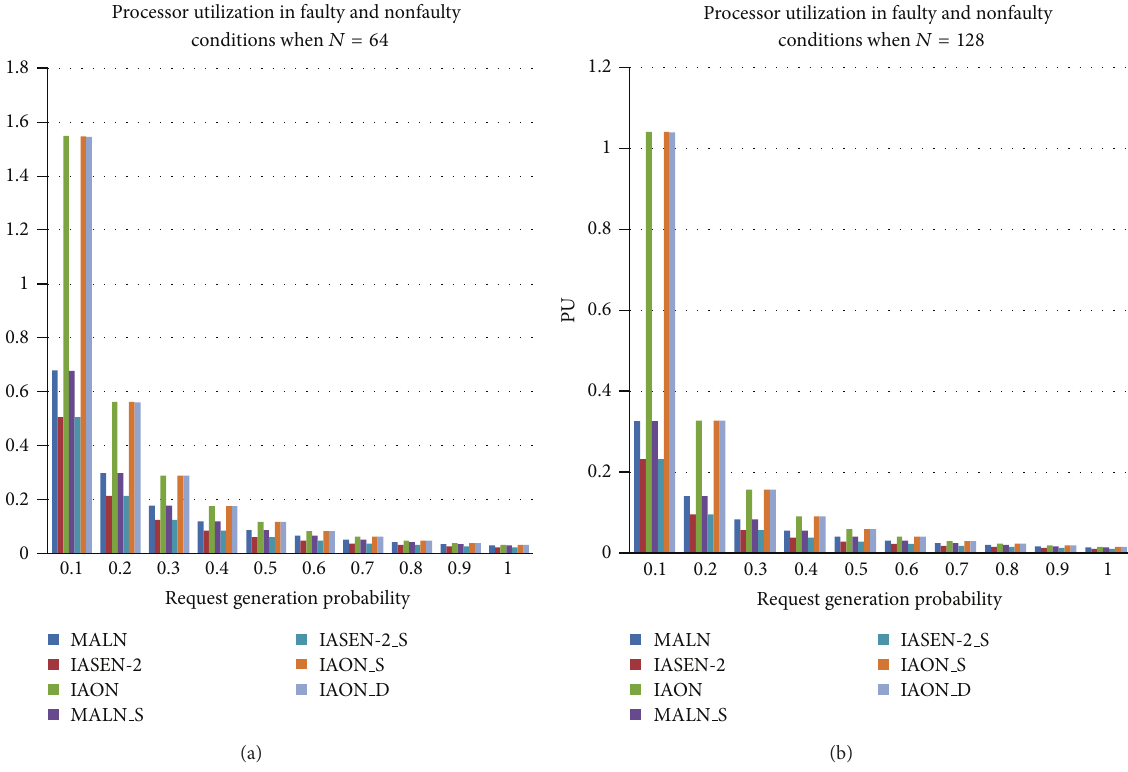
Figure 13: The processor utilization of MALN, IASEN-2, and IAON in faulty and nonfaulty cases, when the network sizes are 64 and 128